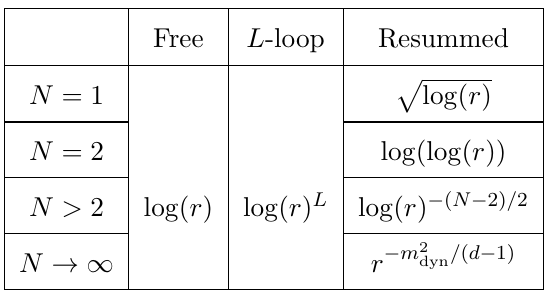
Table 1 . Asymptotic behavior of the resummed two-point function in the massless case ( m = 0) for different values of the number of fields N as the de Sitter invariant distance r resummation of the bi-quadratic interaction terms, the usual logarithmic divergences present in the perturbative calculation (at all N ) are softened when N = 1 , 2 and cured for N > 2. Here m 2 = λ/ (2 V d dyn p